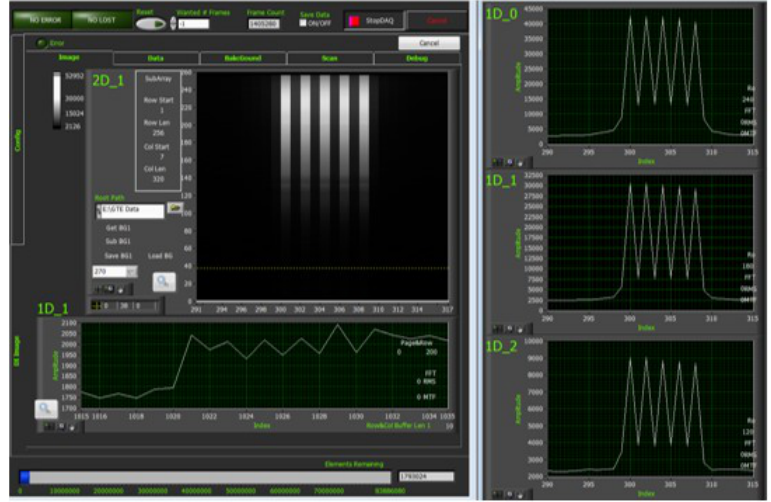
Figure 12. MTF calibration of three bands at the central FOV of high spectral mode (Band 120: MTF = 0.51, Band 180: MTF = 0.54, Band 240: MTF = 0.47).